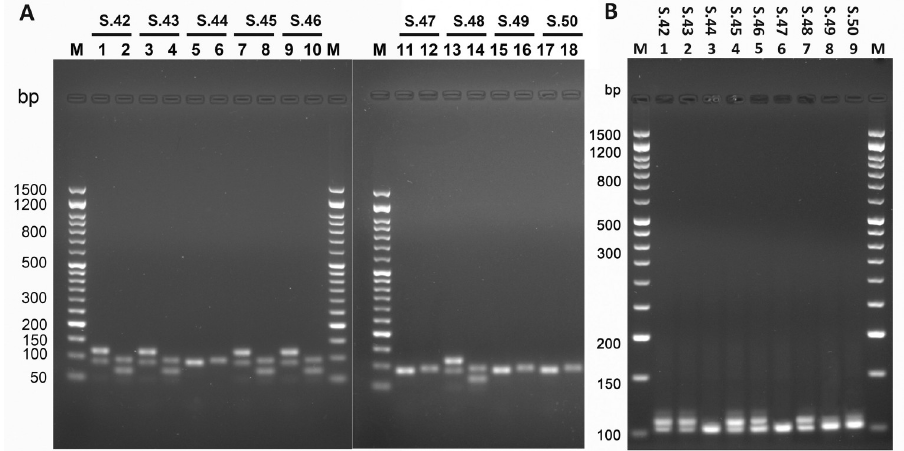
Fig 6. Agarose gel electrophoresis of the amplification products on ancient DNA. (A) The gels were loaded with the qPCR-duplex reaction products obtained with the pairs of primers STS89/TSPY119 , STS95/TSPY67 on male (S42, S43, S45, S46, S48) and female (S44, S47, S49, S50) DNA. In the channels (1,3,5,7,9,11,13,15,17), the products of qPCR with the pair of primers STS89/TSPY119 are shown. In the channels (2,4,6,8,10,12,14,16) are reported the products of qPCR with the pair of primers STS95/TSPY67 . The gels were made with 2.2% agarose and stained with 0.5 μ g/mL ethidium bromide. (B) Amplification fragments generated in qPCR on ancient DNA using the primers AMEL106/112 . The gels were made with 2.9% agarose and stained with 0.5 μ g/mL ethidium bromide. M) marker of molecular weight, Sharp Mass ™ 50—Ready-to-load DNA Ladder (Euroclone